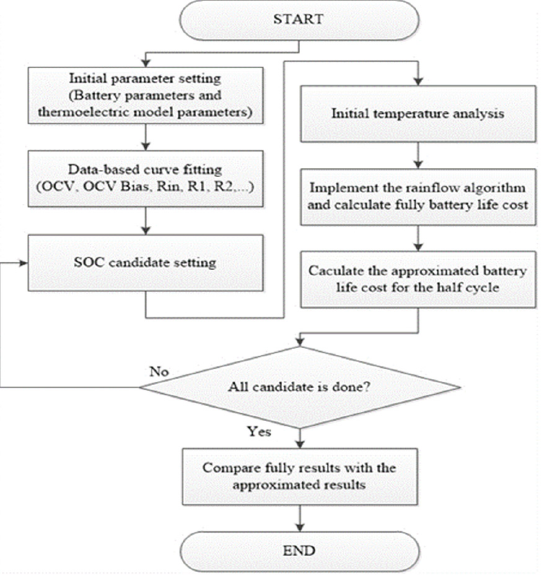
Figure 3. Life-cycle cost comparison flowchart for cycle approximation.